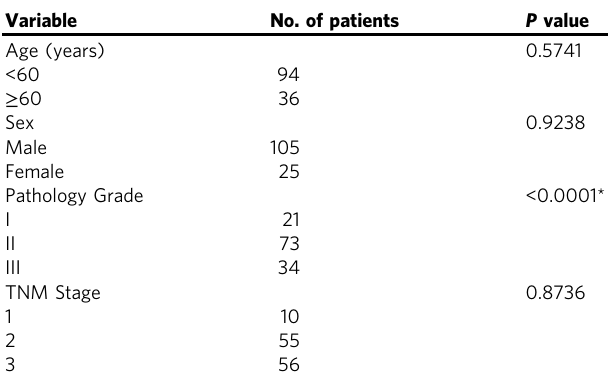
Table 1 Clinical and pathological information of 130 HCC patients included in